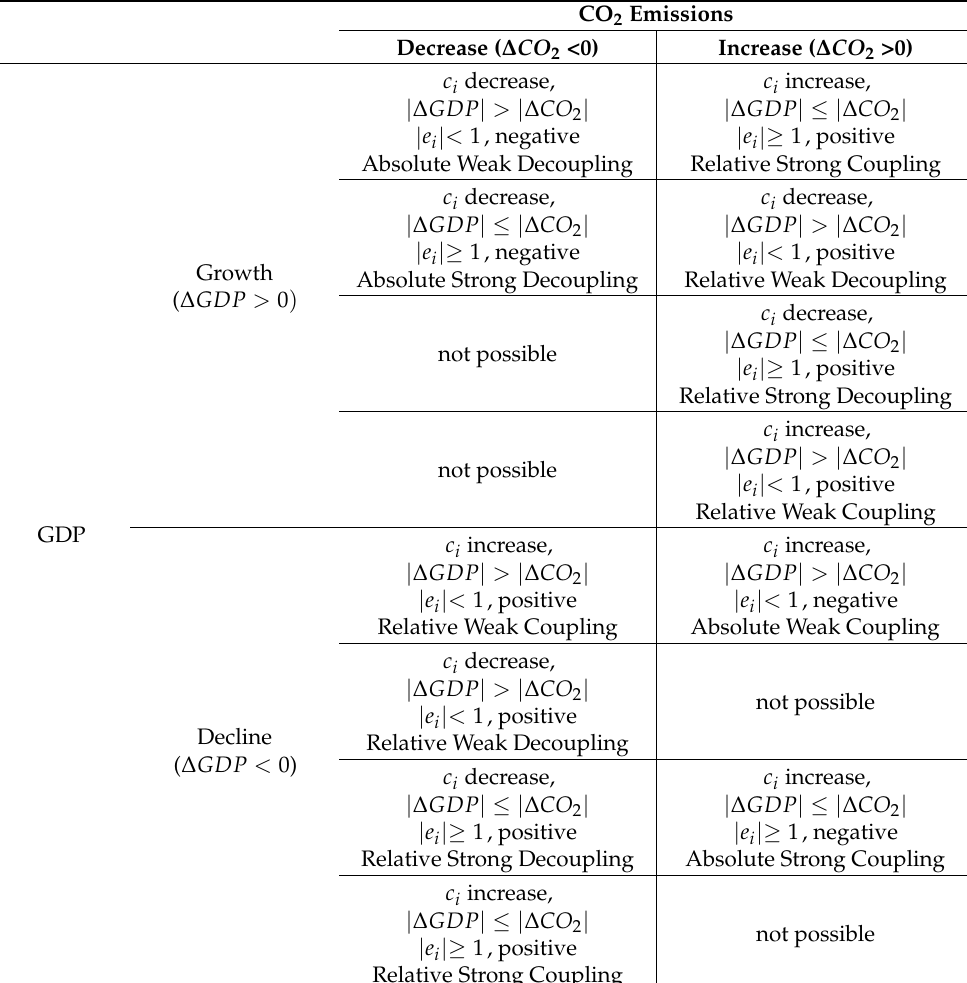
Table 1. Decoupling